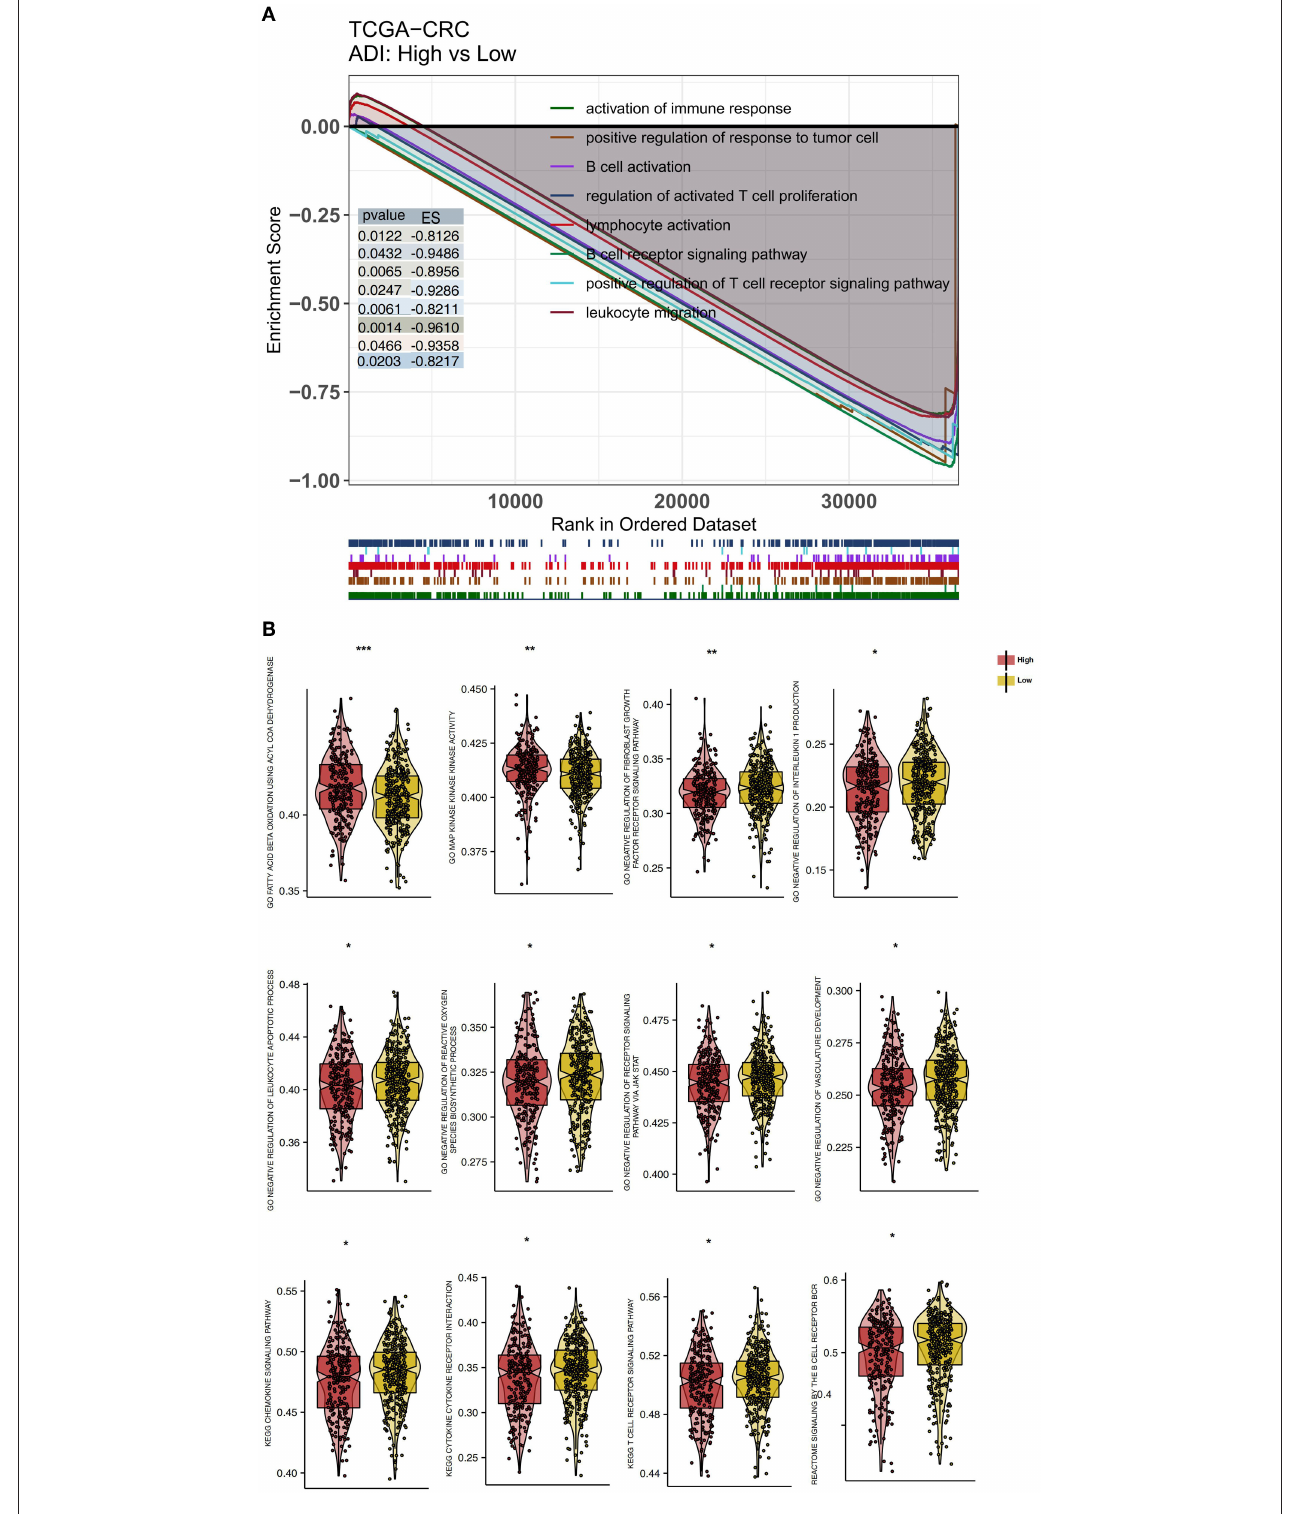
FIGURE 6 | Differentially enriched biological functions of the high-ADI and low-ADI groups of the TCGA-CRC cohort, identified by transcriptome analysis. (A) The results of the GSEA. The color of the curve corresponds to the font color of each pathway. GSEA of hallmark gene sets were downloaded from the Molecular Signatures Database (MSigDB). Each run was performed with 1,000 permutations. Enrichment results with significant differences between the high-ADI and low-ADI tumors are shown. (B) Boxplot depicting the significant mean differences in ssGSEA scores between the high-ADI and low-ADI tumors in the TCGA-CRC queue. * P < 0.05; ** P < 0.01; *** P <